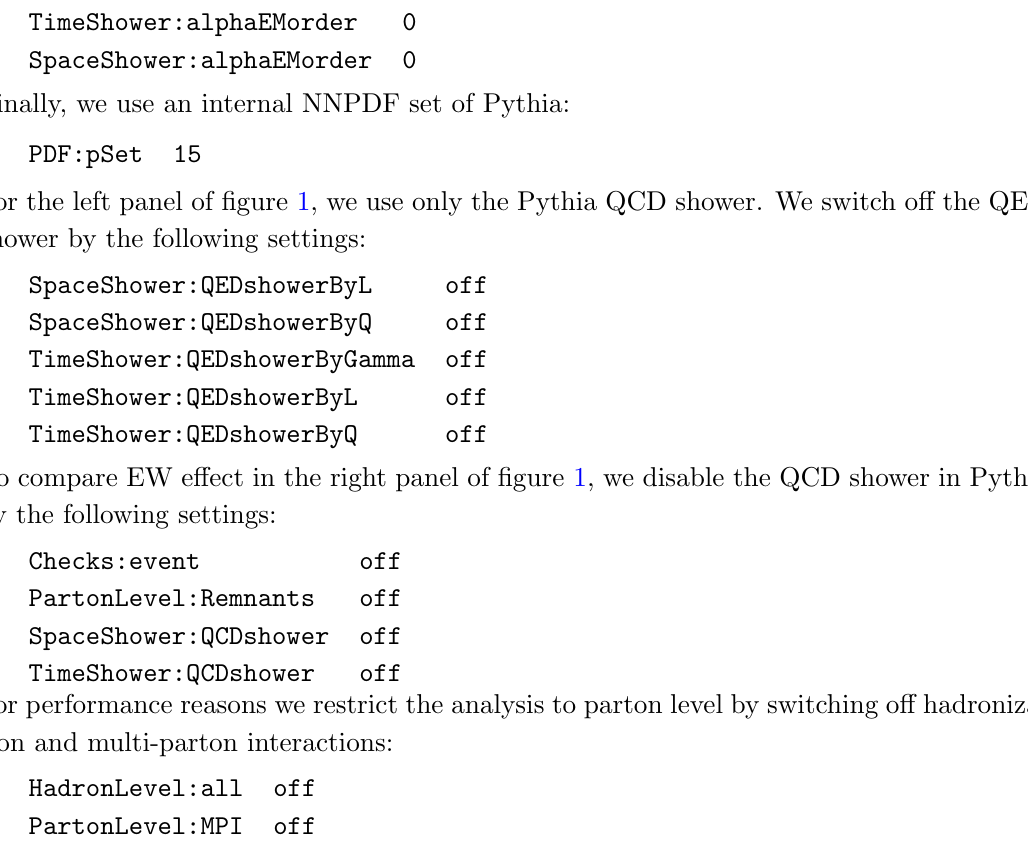
Moreover, we use the (cid:12)ne-structure constant in the Thomson